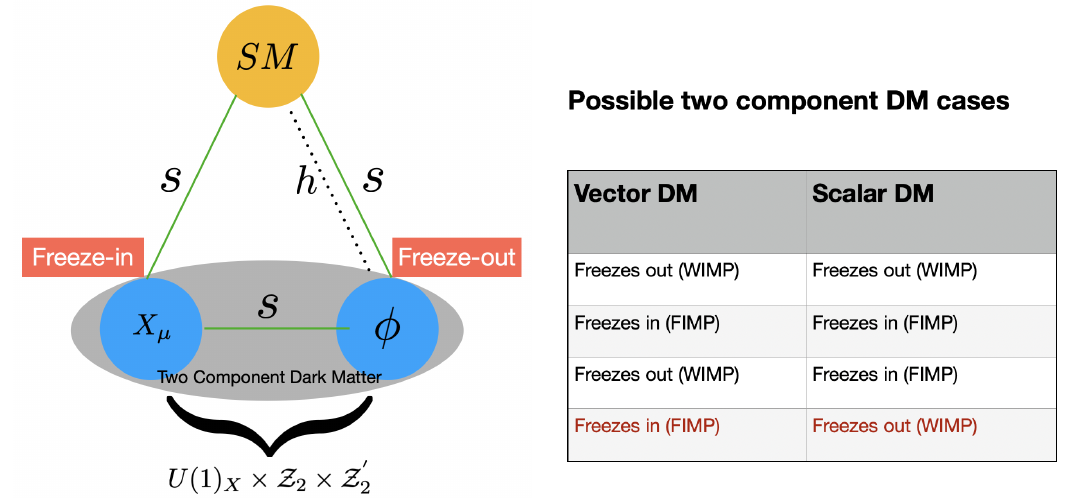
Figure 1 . Left: a cartoon depicting the DM components in the model and their interactions to visible sector and amongst them (see text for notation); right: possible scenarios in the two component DM set-up, the one in colour is considered in this